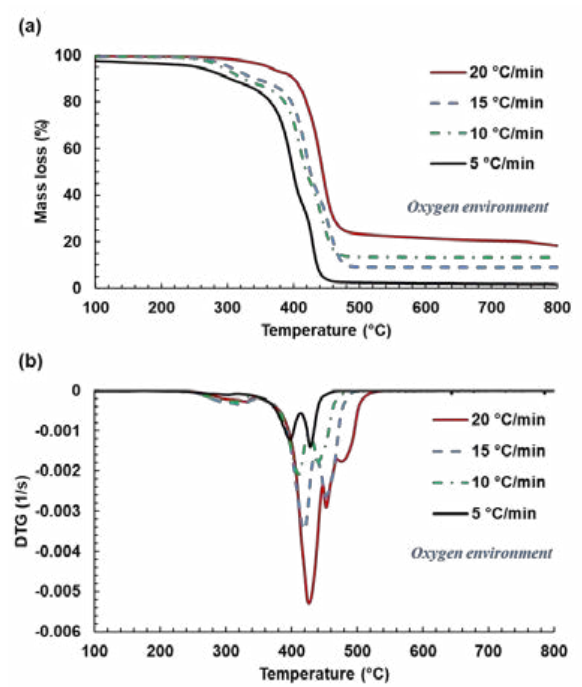
Fig. 4: (a) TGA and (b) DTG for combustion of pellets at 5-20 °C/min